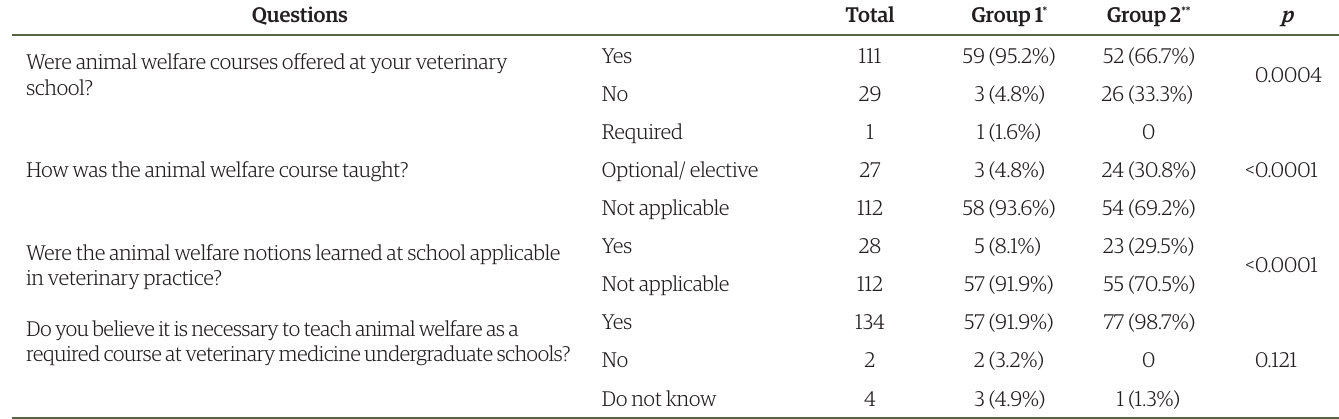
Table 3. Perception of animal welfare training and application in professional practice per group.